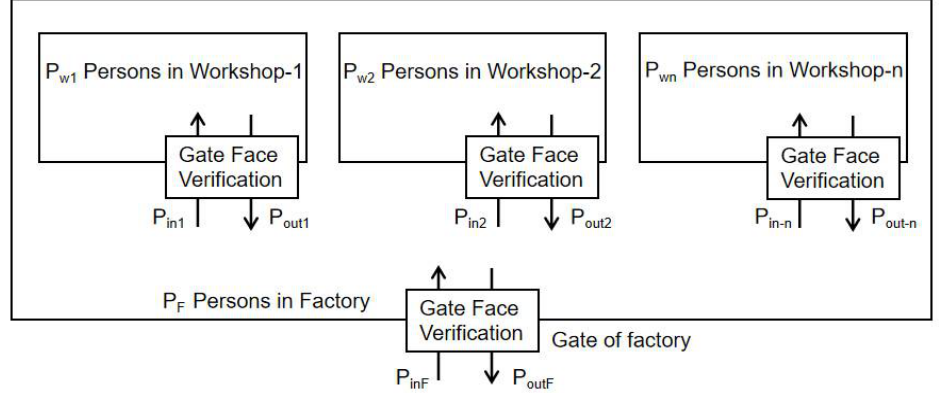
Figure 1. The person tracking system in a hazardous goods factory using gate face verification model.